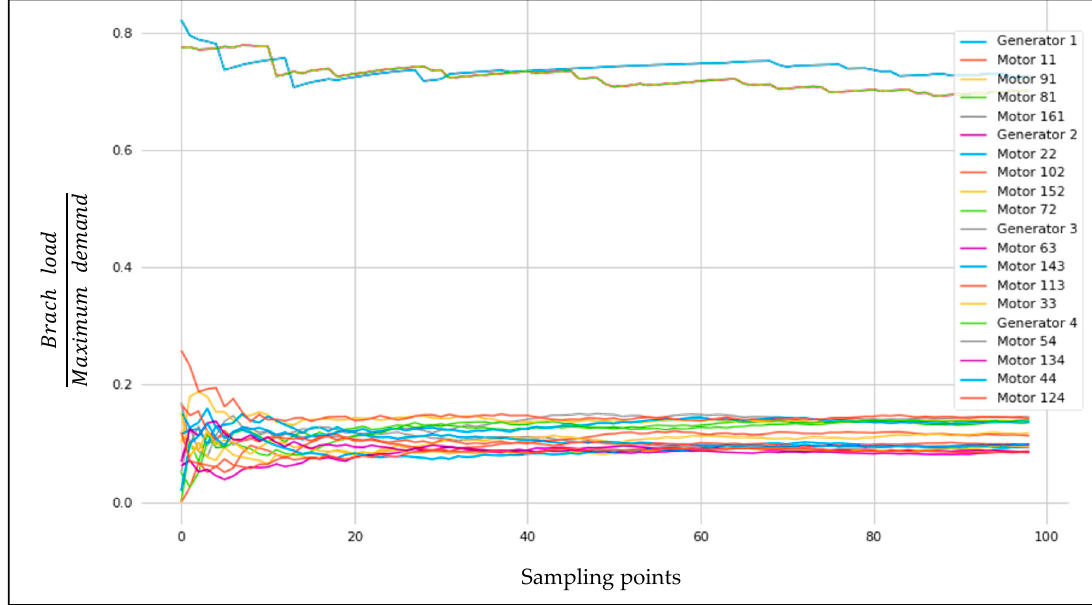
Sampling points Figure 18. NASA N3-X branch loading average, calculated by Latin hypercube, in the cruising condition.